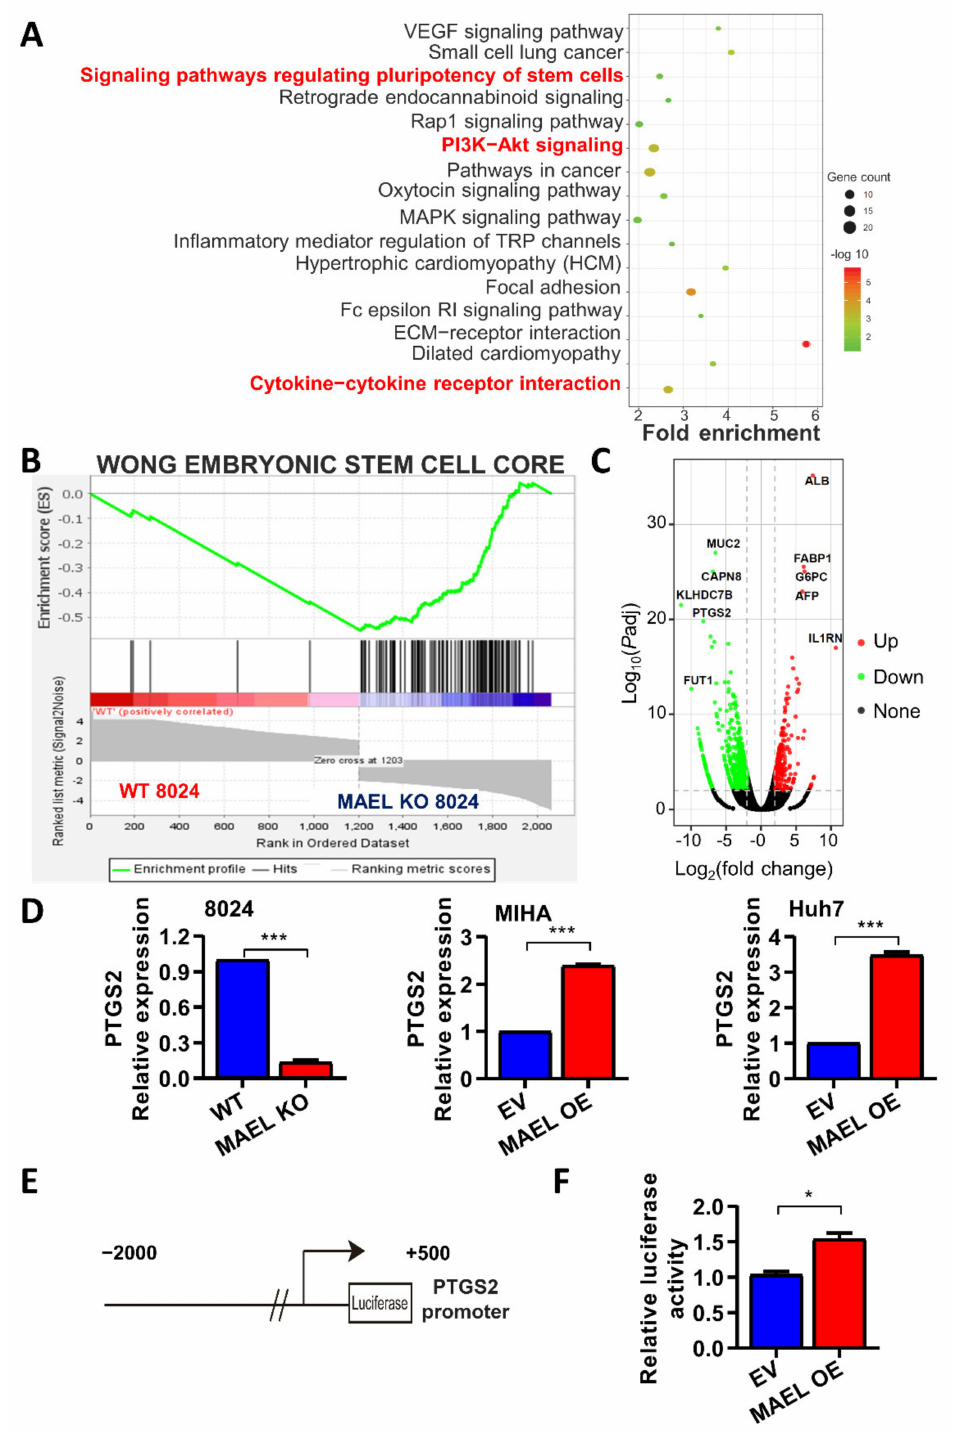
Figure 5. PTGS2 is transcriptionally activated by MAEL and involved in the MAEL-mediated regulation of stemness in HCC. ( A ) The plot of KEGG pathways in MAEL wildtype versus knockout PLC8024 cells. The color and size of the bubble represent the enrichment significance and gene numbers enriched in a pathway, respectively. ( B ) Gene set enrichment analysis (GSEA) demonstrates MAEL modulation significantly enriched in embryonic stem cell core. ( C ) The volcano diagram illustrates differentially expressed genes by MAEL knockout. Spots indicate genes differentially expressed between the two groups (red, upregulated; green, downregulated; gray, not significant genes; –Log 10 Padj > 2, |Log 2 Fold change| > 2). ( D ) Relative mRNA level of PTGS2 validated by